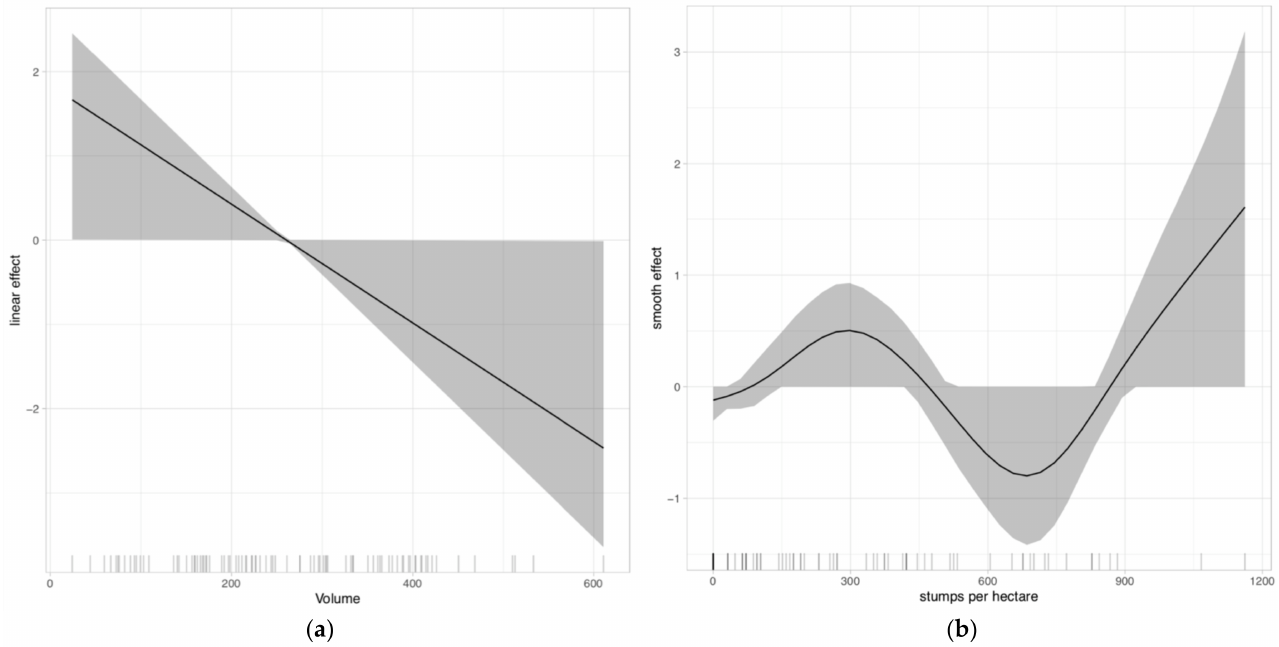
Figure 3. Predicted ant occurrence ( a ) smooth terms describe the relationship with volume of living wood, with their 95% credible bands; ( b ) smooth terms describe the relationship with number of stumps, with their 95% credible